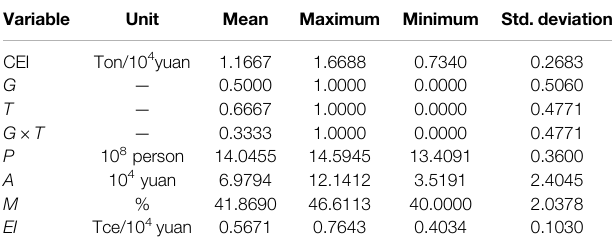
TABLE 3 | Descriptive statistics of variables.